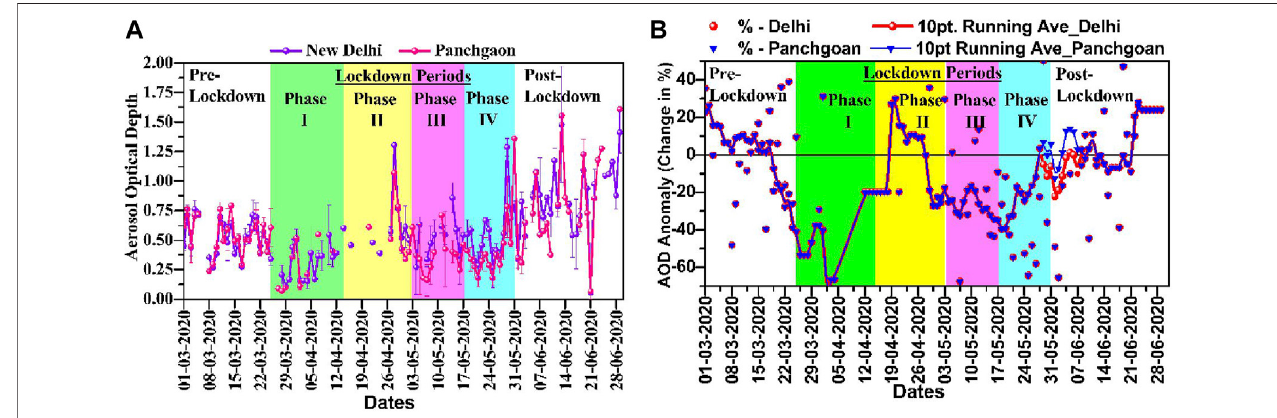
FIGURE4|(A) Dailyvariationintotalcolumnaerosolopticaldepth(AOD)obtainedfromMODISsatelliteretrievalsatNewDelhiandPanchgaon, (B) sameas (A) but for anomalies (2020 minus climatology). Climatology is obtained for the period 2010 –